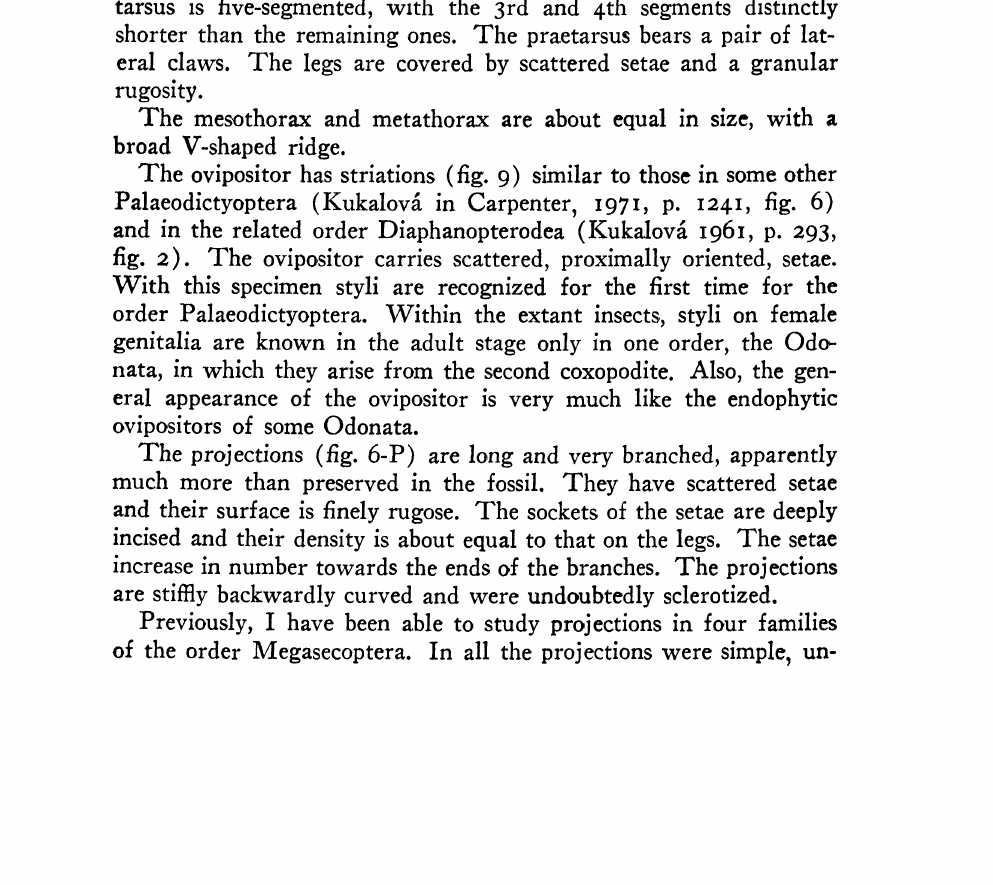
Figure 9. Monsteropterum moraicum n.sp. Enlarged ovipositor with striations, scattered setae and stylus (S), resembling the endophytic ovi- positor of Odonata. Lower Permian of